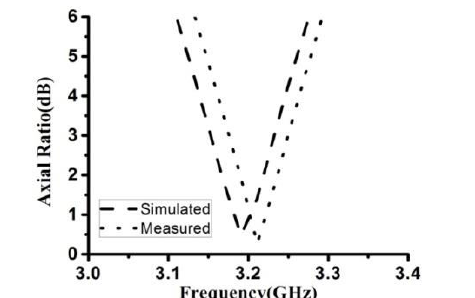
Figure 10: Axial Ratio characteristics of the proposed antenna The radiation patterns of the proposed antenna at the lower and upper resonating bands (2.4 GHz and 3.2 GHZ) are shown in the Fig. 11& 12 respectively. The gain of the proposed antenna is given in Fig. 13.